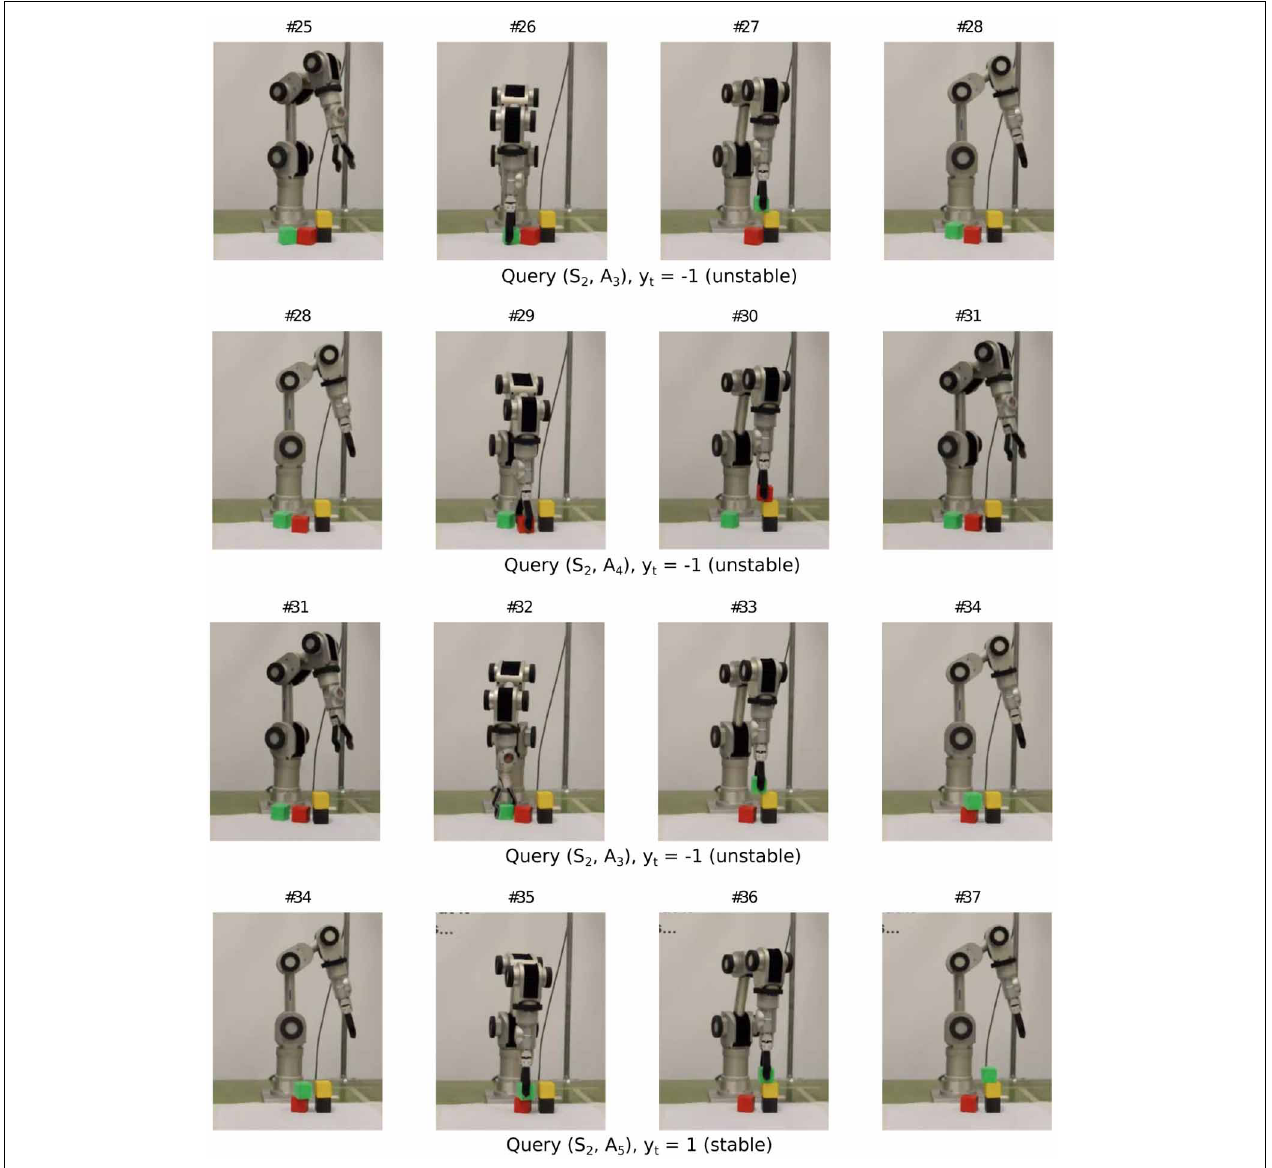
FIGURE 12 | Sample query sequence on real robot